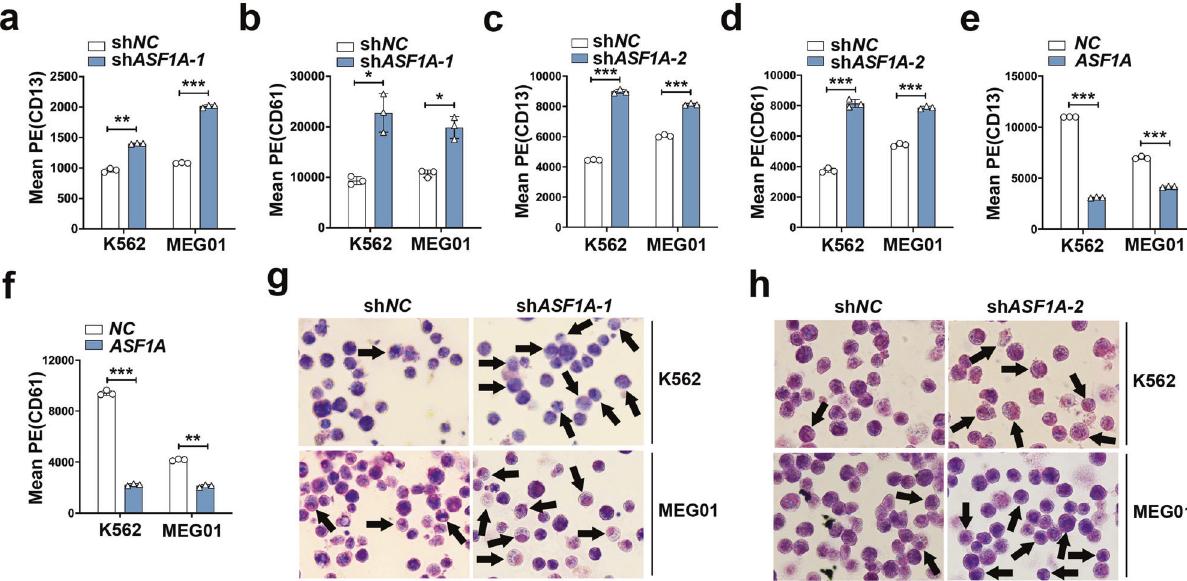
Fig. 2 ASF1A suppresses cell differentiation to accelerate CML transformation. a – d FACS analysis of CD13 and CD61 levels in K562 and MEG01 cells expressing either empty vector (sh NC ) or sh ASF1A-1 /sh ASF1A-2 . e , f FACS analysis of CD13 and CD61 levels in K562 and MEG01 cells expressing either empty vector ( NC ) or ASF1A . g , h Cell morphological assays assessed by May-Grunwald Giemsa staining of K562 and MEG01 cells expressing either empty vector (sh NC ) or sh ASF1A-1 /sh ASF1A-2 . Arrows indicate cells with matured morphology, which exhibit kidney-shape nucleus and decreased nuclear/cytoplasm ratio. Statistical signi fi cance was determined by Student ’ s t test. Data are shown as mean ± standard deviation (SD). Data are shown as a representative result with three repeats from three independent experiments. The cell lines are applied with three independent lentiviral infections in a – h . * P < 0.05, ** P < 0.01, *** P < 0.001.